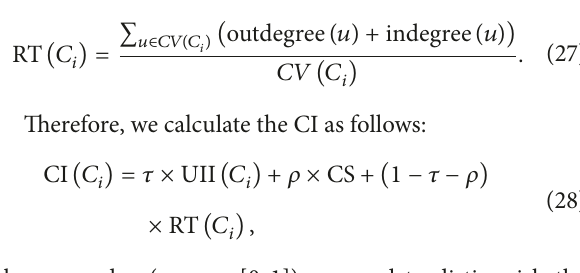
Table 2: Data structure and description of the user theme informa- tion (microblogs).